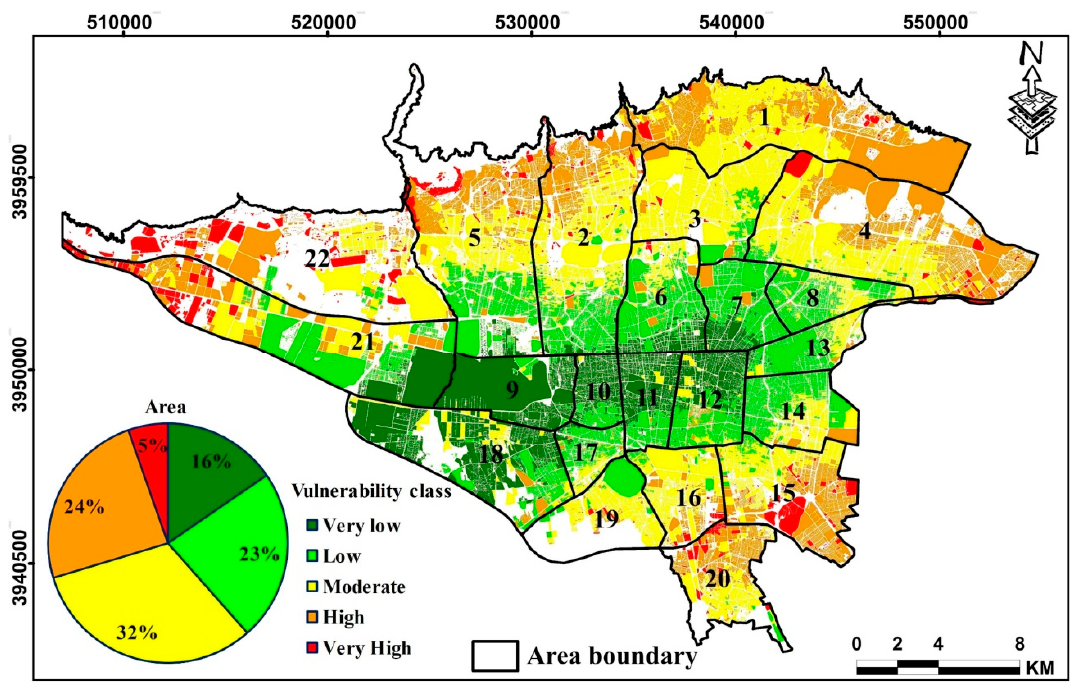
Figure 14. Classified map of spatial distribution and percentage of vulnerable areas to earthquakes (numbers 1 to 22 represent the urban districts of Tehran).